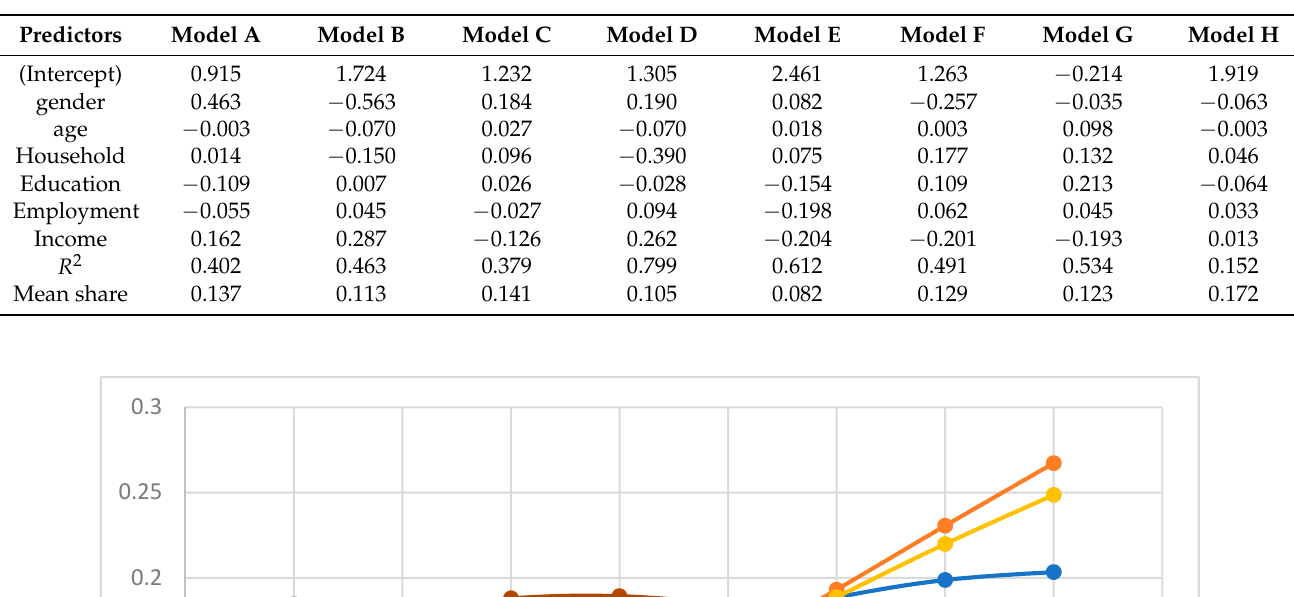
Table 4. Parameters of the exponential models for priority by demographics.